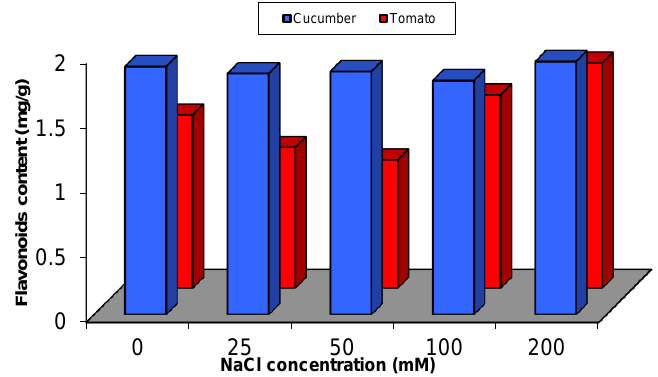
Figure 5. Flavonoids content of cucumber and tomato under NaCl stress.